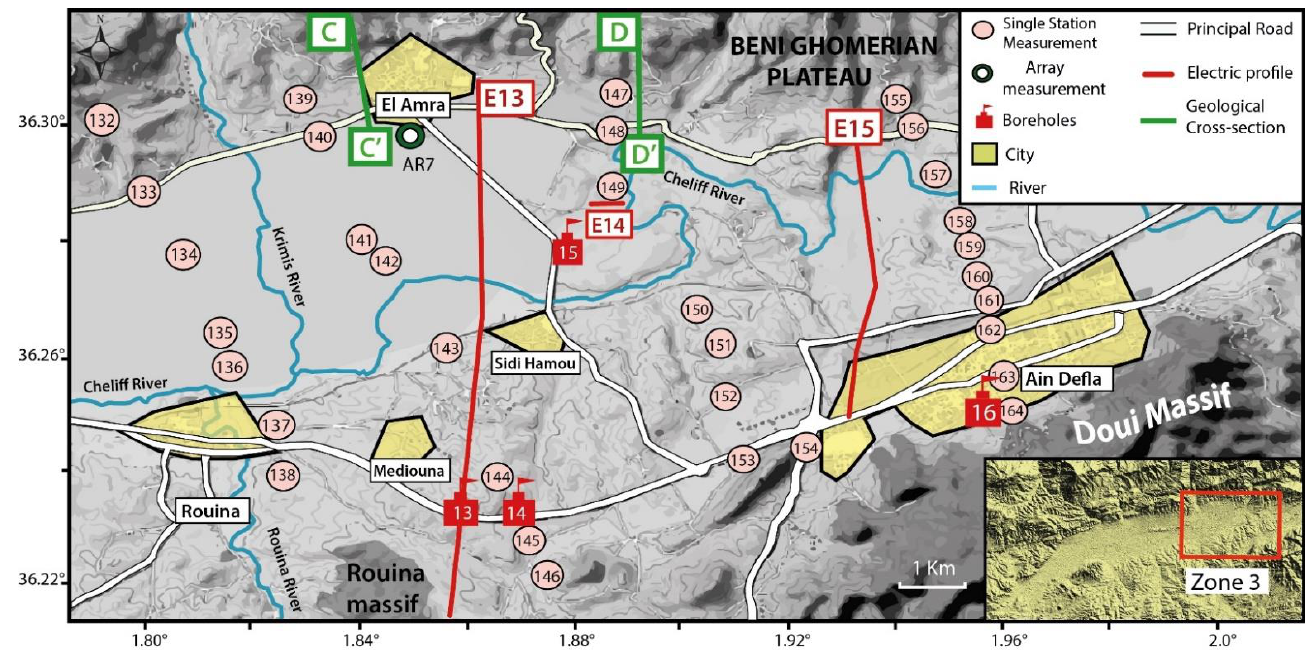
Figure 5. Compiled data in Zone 2.